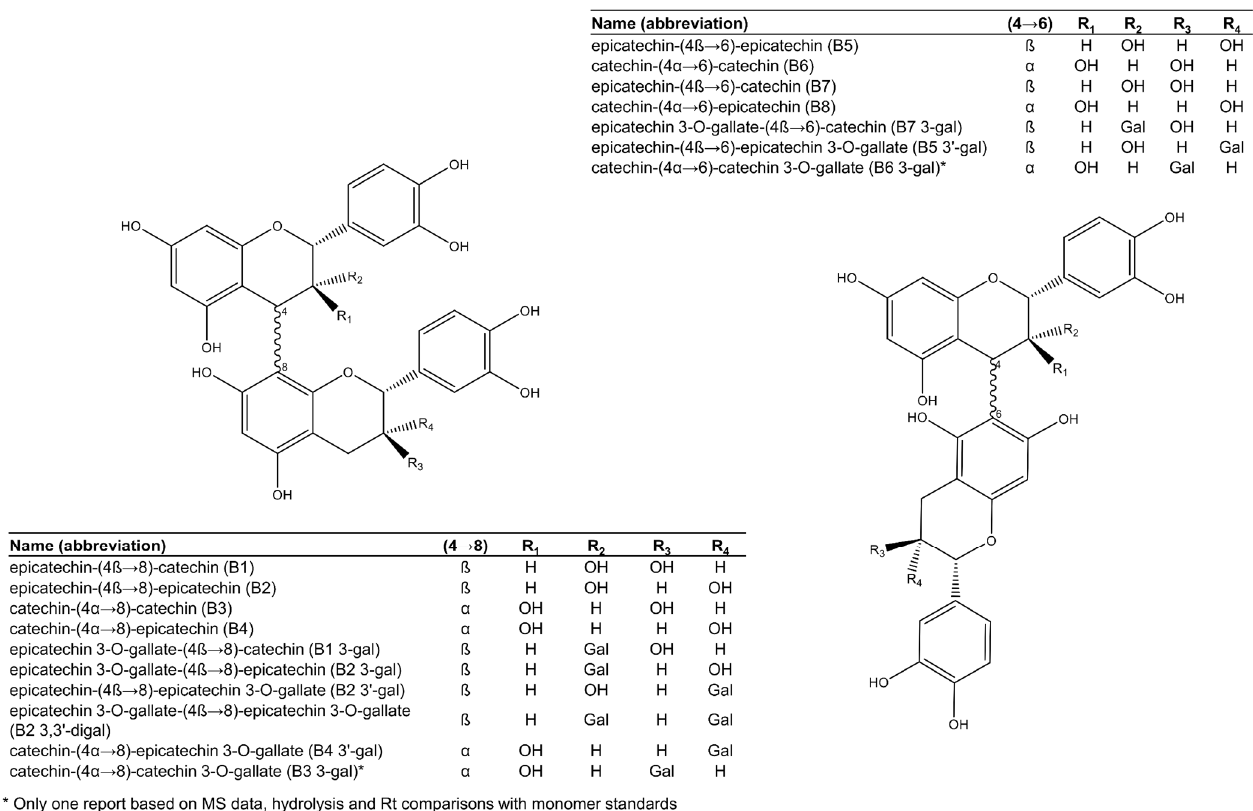
Figure 2. Procyanidin dimers reported in grape